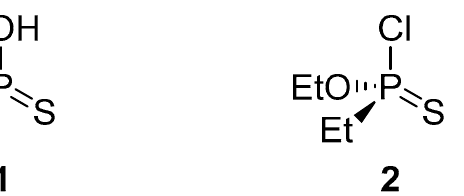
Figure 1. Structures of optically active acyclic thiophosphonic acid ( 1 ) and the corresponding thiophosphonyl chloride ( 2 ) used in studies of nucleophilic substitution at phosphorus.